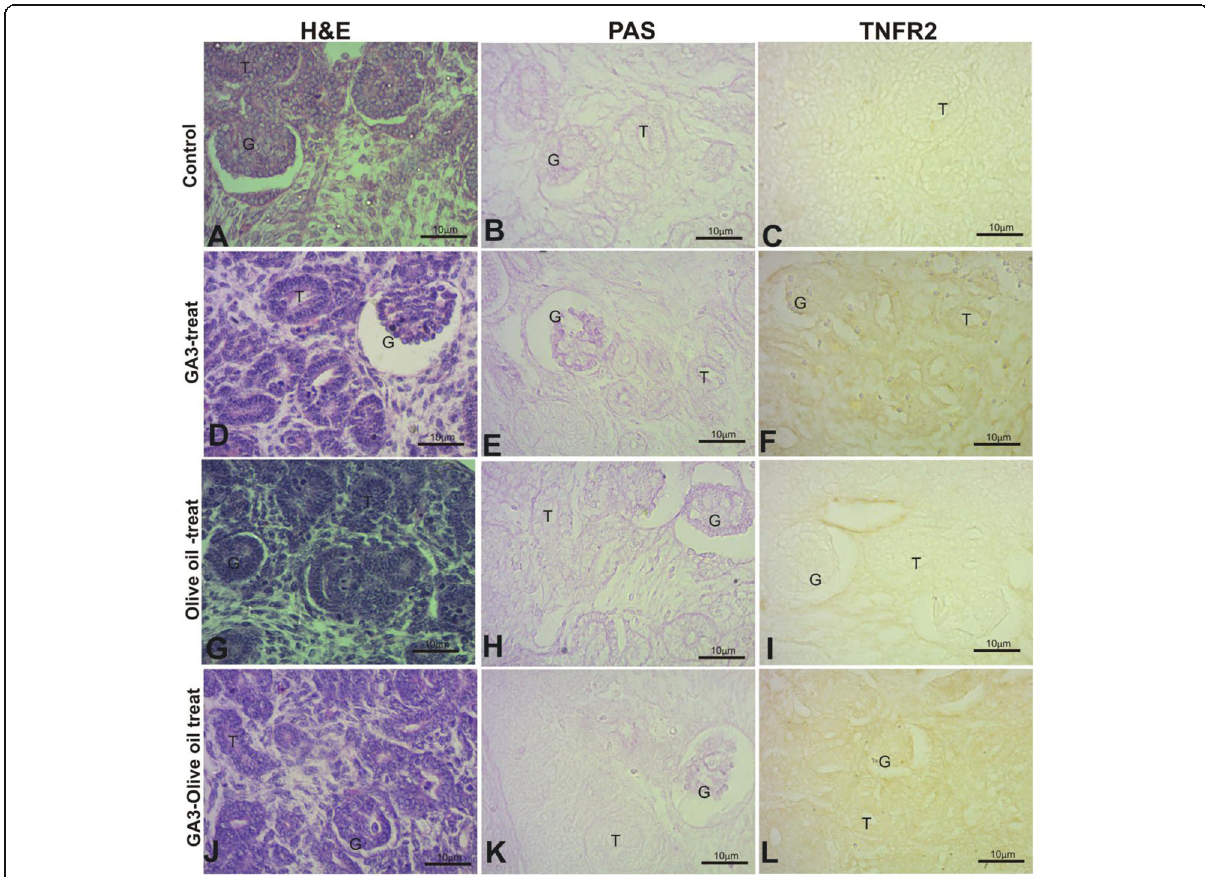
Fig. 6 Photomicrographs of H&E-, PAS-, and TNFR2-stained sections of developing kidney at E14. The developing kidney at E14 of gestation in the studied groups showed glomeruli (G) and tubules (T). There is no histopathological alteration noted in the developing kidney at E14 at the level of H&E, PAS, and TNFR2 stains in the studied groups; GA3 ( d – f ), olive oil ( g – i ), GA3-olive oil ( j – l ) as compared to control ( a – c ). Scale bar ( a – l ) = 10 μ